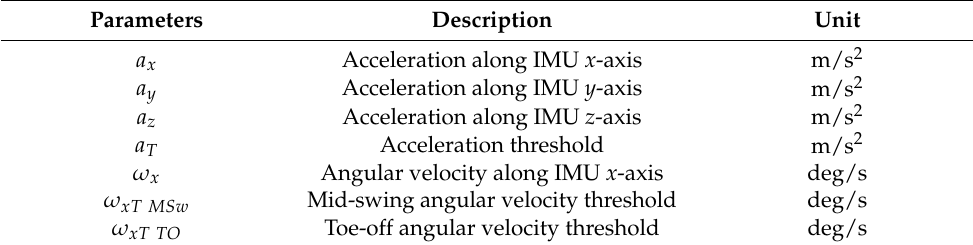
Table 1. List of parameters implemented into the IMU-based